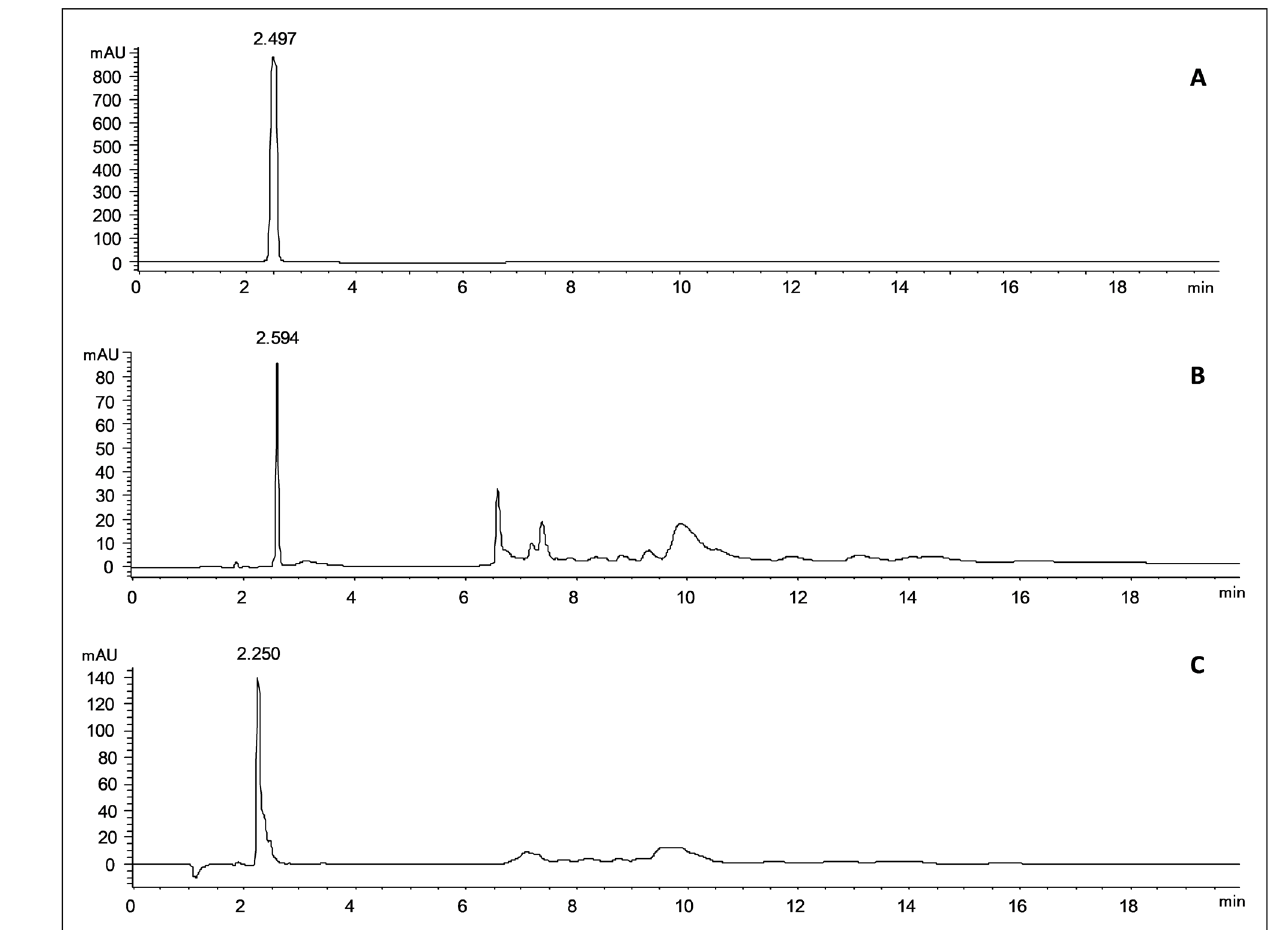
FIGURE 1 - Chromatographic profile of the 5-CQA standard (A), CP01/5-CQA coelution (B) and CP02/5-CQA coelution (C) by HPLC-UV. The detection wavelength was at 330 nm. CP01: glycerin (GLY - 70 %) and grain alcohol (GA - 30 %); CP02: propylene glycol (PG - 70 %) and grain alcohol (GA - 30 %); 5-CQA: 5-O-caffeoylquinic